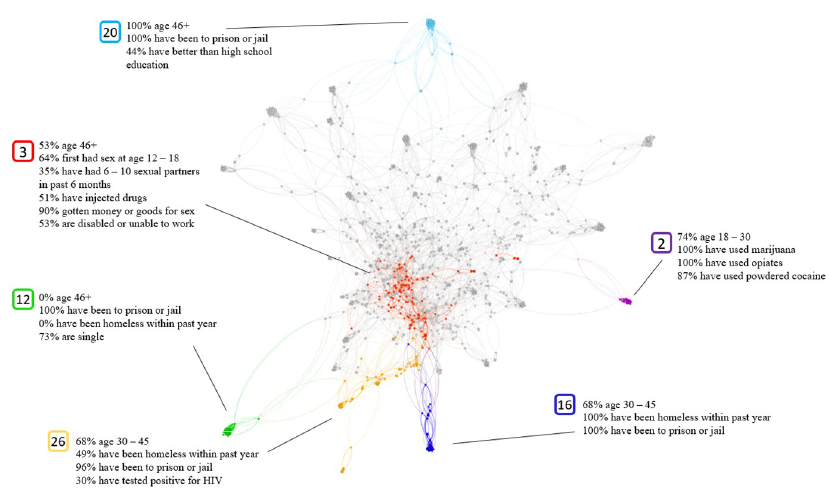
Fig 5. Insurance